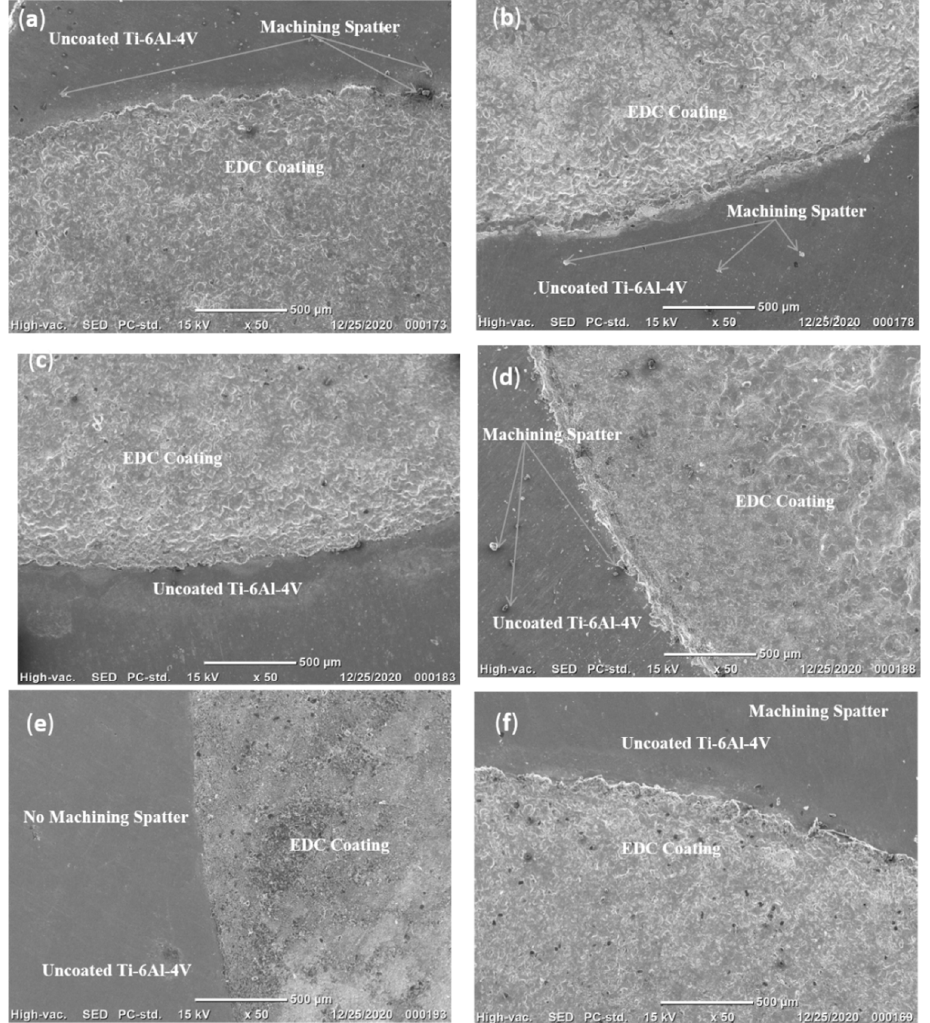
Figure 7. SEM images showing both coating and uncoating surface on substrate for six experiments, shown in the order of (a) to (f) respectively.